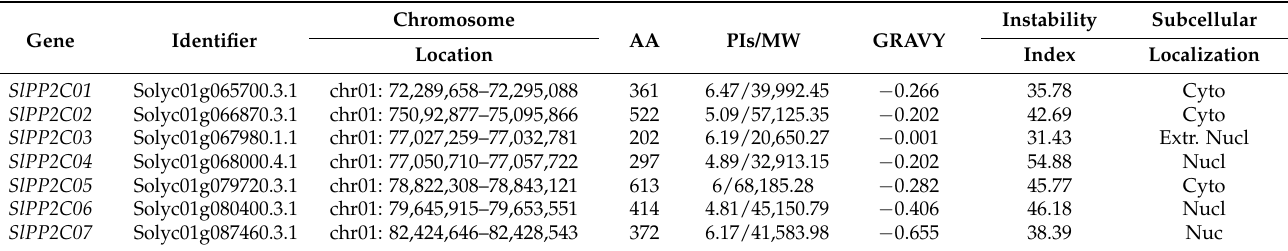
Table 1. Information of the protein phosphatase 2C ( PP2C ) gene family in